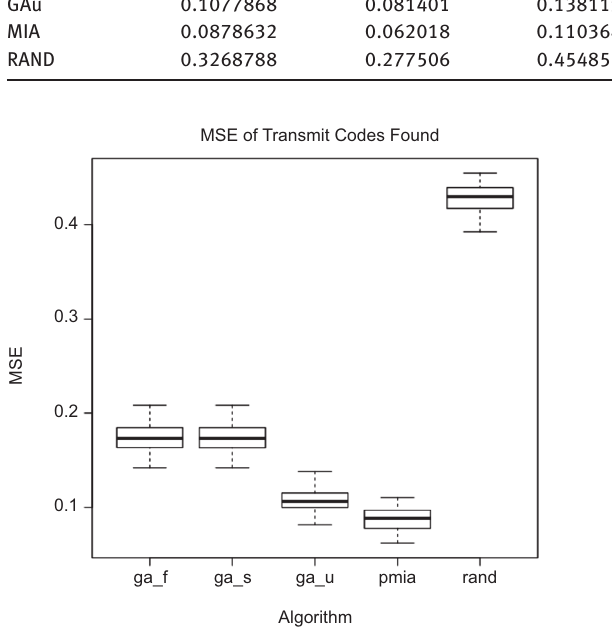
Figure 4. Length 51 32 PSK Box Plot Results.